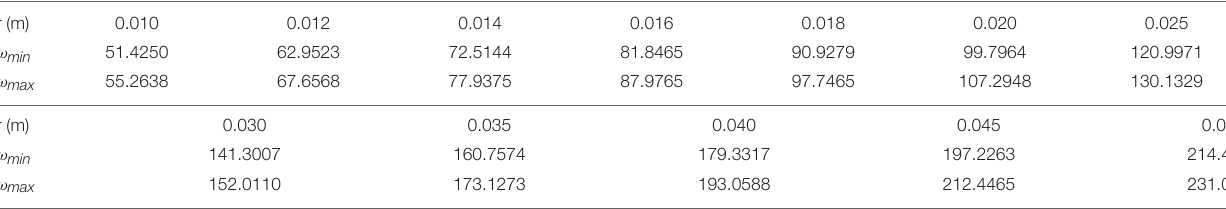
TABLE 1 | Values of the extrema of the gap with respect to the radius of the thin channel, for the Helmholtz resonator like in Figure 3 .